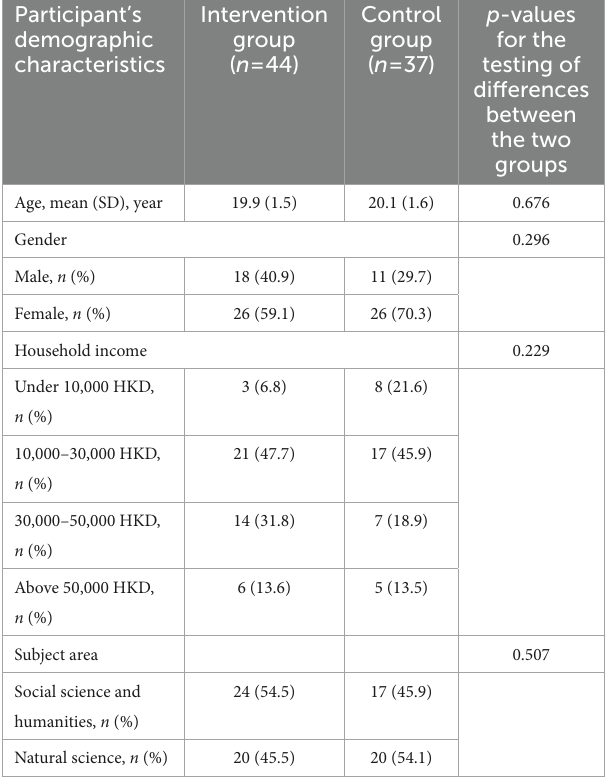
TABLE 2 Demographic characteristics of students in the intervention group and control group. Participant’s demographic